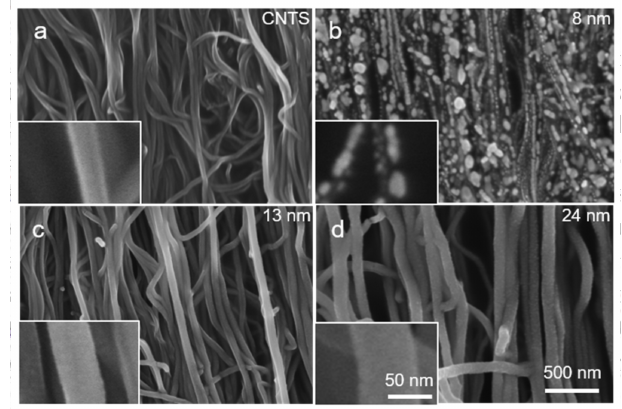
Figure 3. ( a – d ) The SEM images of the Cu t -CNTS with different thickness of